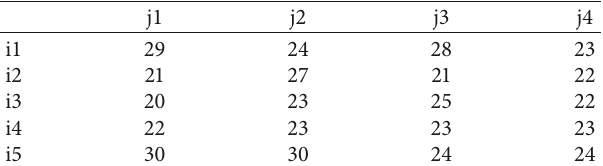
Table 7: Cost of transferring relief goods from supplier to central warehouse.